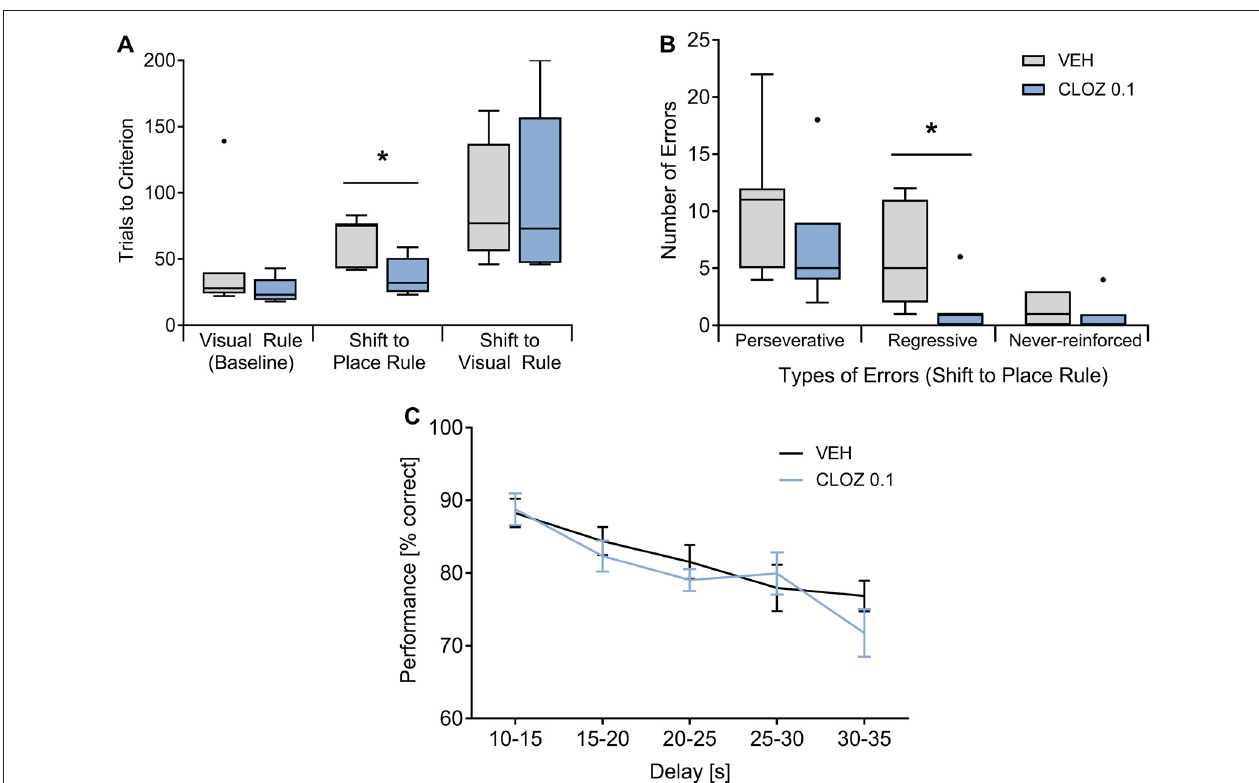
FIGURE 2 | CLOZ increases cognitive flexibility but does not affect working memory performance. (A,B) Strategy set-shifting: during the visual baseline, rats ( n = 7 per group) did not differ with respect to performance, whereas they reached the criterion during the shift from the visual to the place rule in fewer trials (CLOZ 0.1 mg/kg vs. VEH; p = 0.011). Trials to criterion were not different for the shift back to visual rule. The better performance during the shift to the place rule went along with a lower number of old errors (i.e., responses that are correct according the previous rule; p = 0.016). This was caused by a decrease in the number of regressive ( p = 0.016) but not perseverative errors, indicating that CLOZ improves rule maintenance after the switch. The number of never-reinforced errors was not different. Data shown as median (P 25 , P 75 ). ∗ p < 0.05. (C) Delayed alternation task: performance decreased significantly when longer delays separated two consecutive choice trials ( F ( 4,72 ) = 9.42; p = 4 × 10 − 6 ), but there was no difference between VEH or CLOZ treatment ( F ( 1,18 ) = 0.93; p = 0.347; n = 19 rats). Data are expressed as mean ±